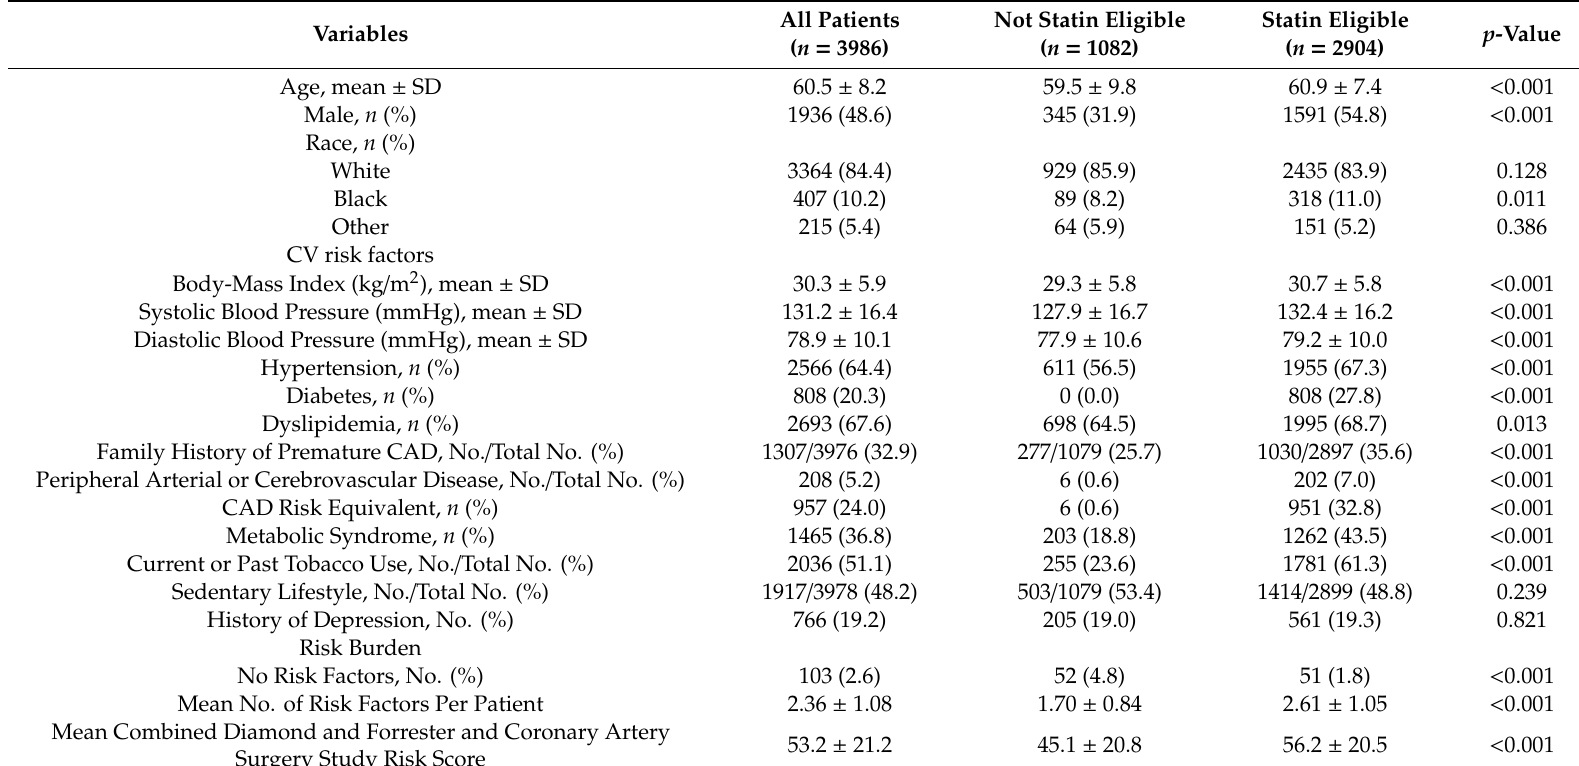
Table 1. Patient demographics, cardiovascular risk factors, clinical presentation, risk score,